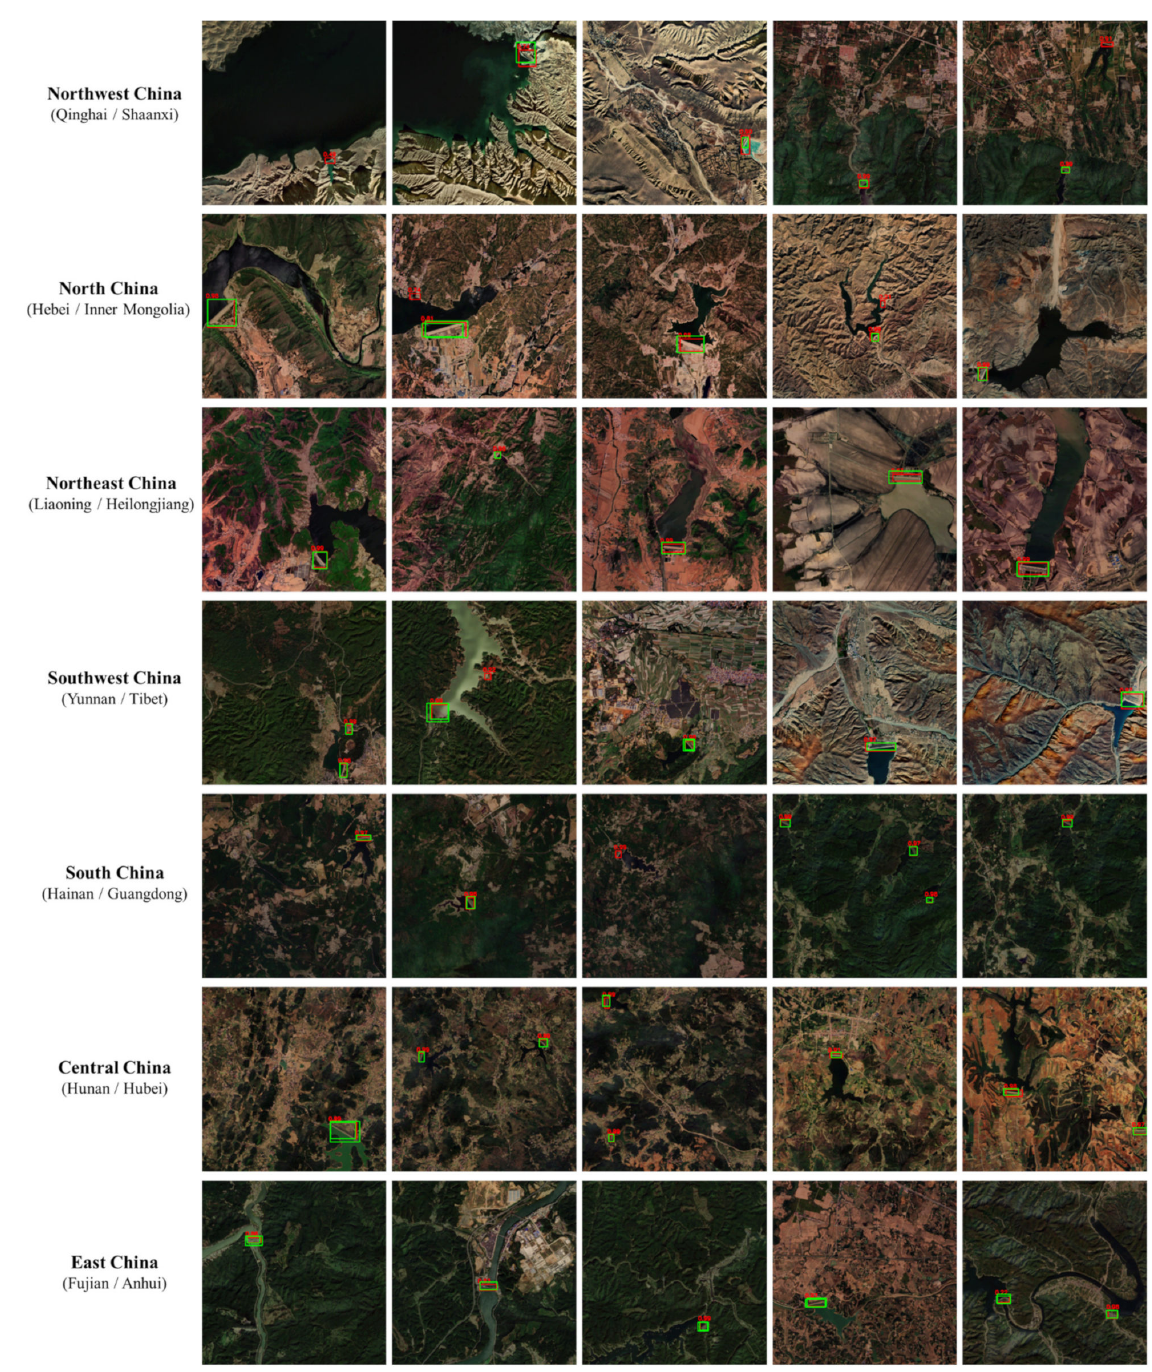
Figure 15. Visualization of detection results of instance-level in different geographic regions, where each row represents a geographic region and contains images from the two provinces. Red bounding boxes denotes the prediction of the model, while green bounding boxes denote ground truth